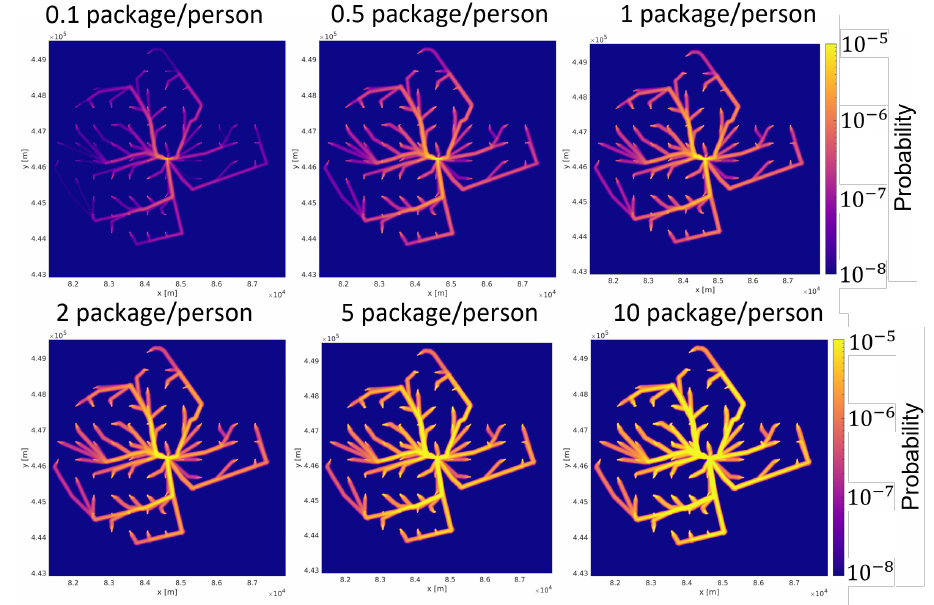
Figure A4. Annual IR with different flight